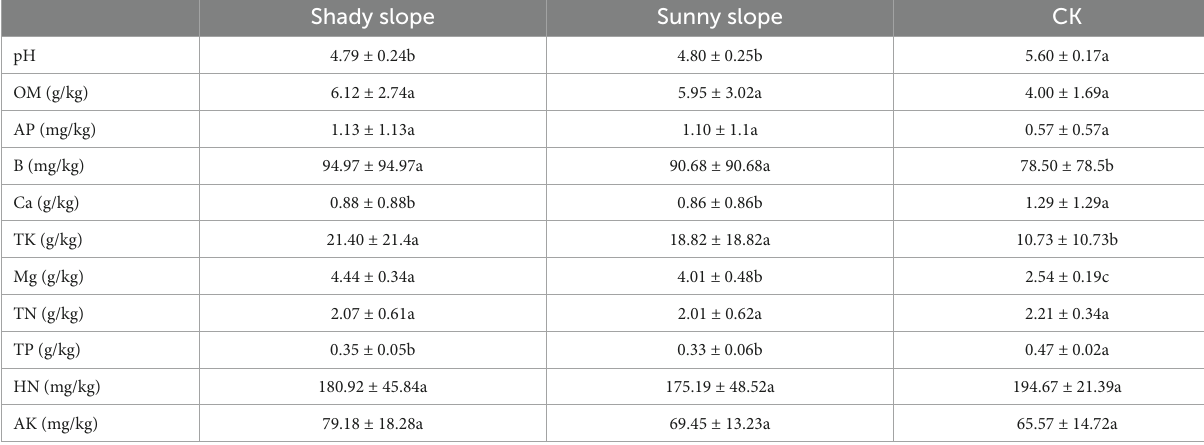
Data are given as mean ± SD. Values in the columns followed by the same letter(s) are not significantly different ( p < 0.05) according to one-way ANOVA.